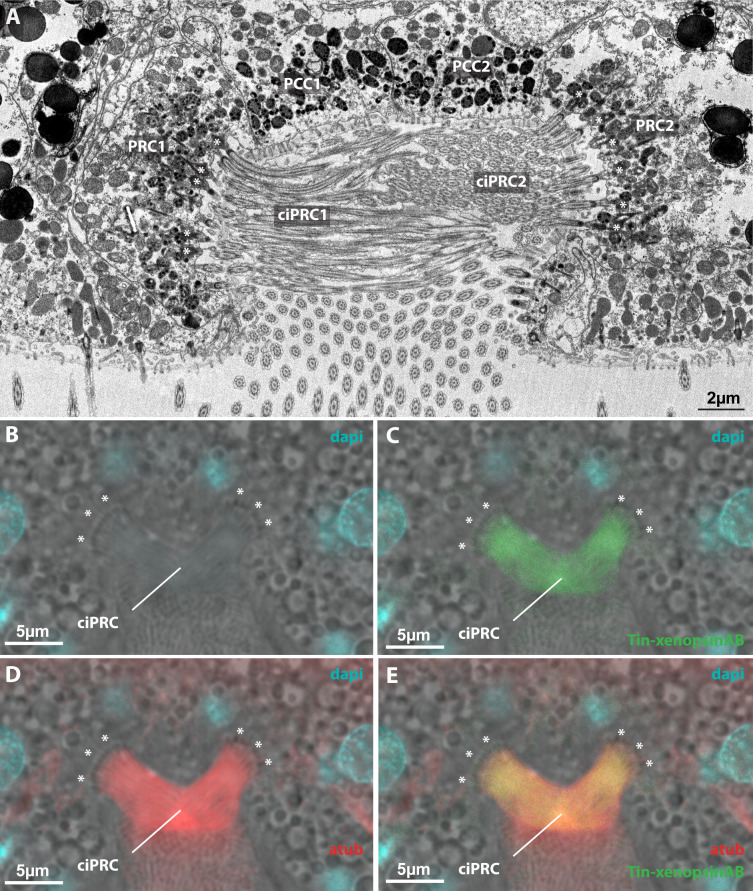
Subcellular localization of xenopsin in the median eye of Tricellaria inopinata.(A) Electron microscopic images (chemical fixation) showing two photoreceptor cell1 (PRC1, PRC2) on the lateral sides of the eye invagination. Two pigmented coronal cells (PCC1, PCC2) line the bottom of the invagination. PRC1 and PRC2 send numerous cilia (ciPRC1, ciPRC2) into the lumen of the invagination. The cilia of the PRCs possess basal bodies (white asterisks) and rootlets. (B–E) IHC labeling of Tin-xenopsin and acetylated alpha-tubulin. Same orientation as in (A). Tin-xenopsin protein localizes within cilia projecting from lateral cells into the eye invagination. The basal bodies (white asterisks) are visible inside the eye PRCs.